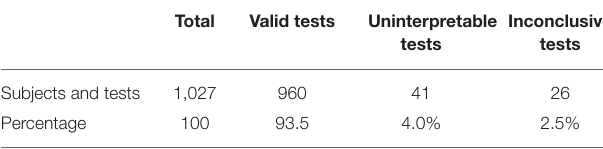
TABLE 1 | Overview of diagnostic tests with